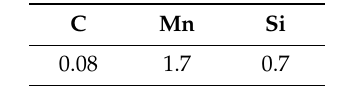
Table 3. Chemical composition for the weld deposit with E 50 4 B 4 2 H5.